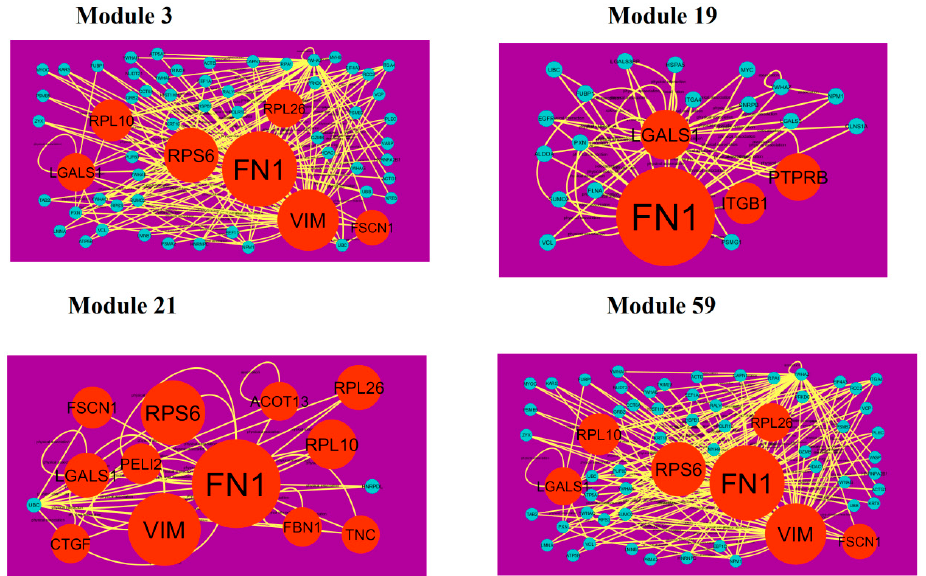
Figure 11. Modules in PPI network. The orange round nodes denote down-regulated genes. Green dots are also genes which are not hub or differential expressed genes. Yellow curve lines is interaction with adjutant genes.